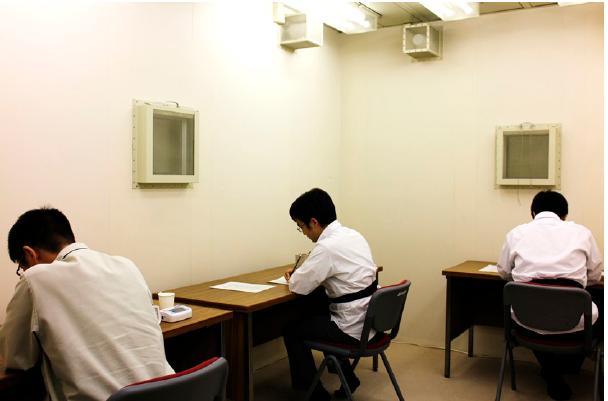
Figure 1. The experiment room in which Japanese cedar wood essential oil was diffused. Three participants entered the experiment room at the same time, sat facing the wall, performed a monotonous task during the work period, and then remained in their seats during the rest period.